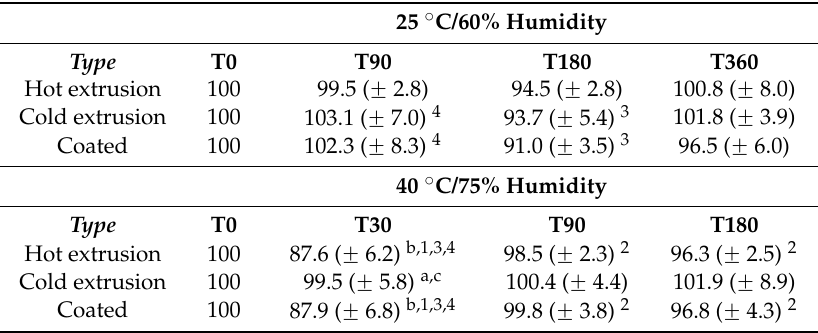
Table 4. Retention of zinc overtime, as percentage from zinc concentration in uncooked fortified rice prior to storage (T0).